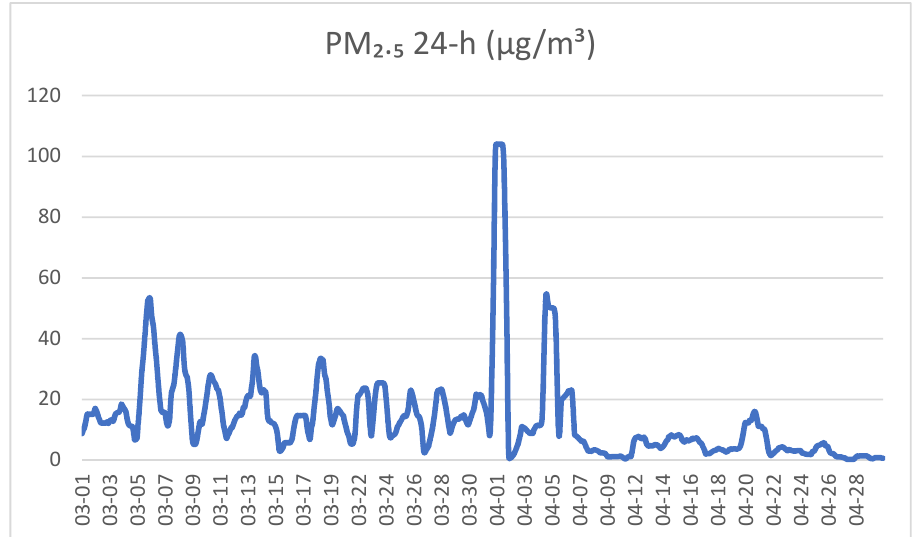
Figure 2. Average 24 h concentrations of PM 2.5 ( µ g/m 3 ) measured in Warburton between 1 March and 30 April 2016. Health assessments were conducted on 1 April 2016 and 19–21 April 2016. Note that planned burns were conducted near Warburton during the study.